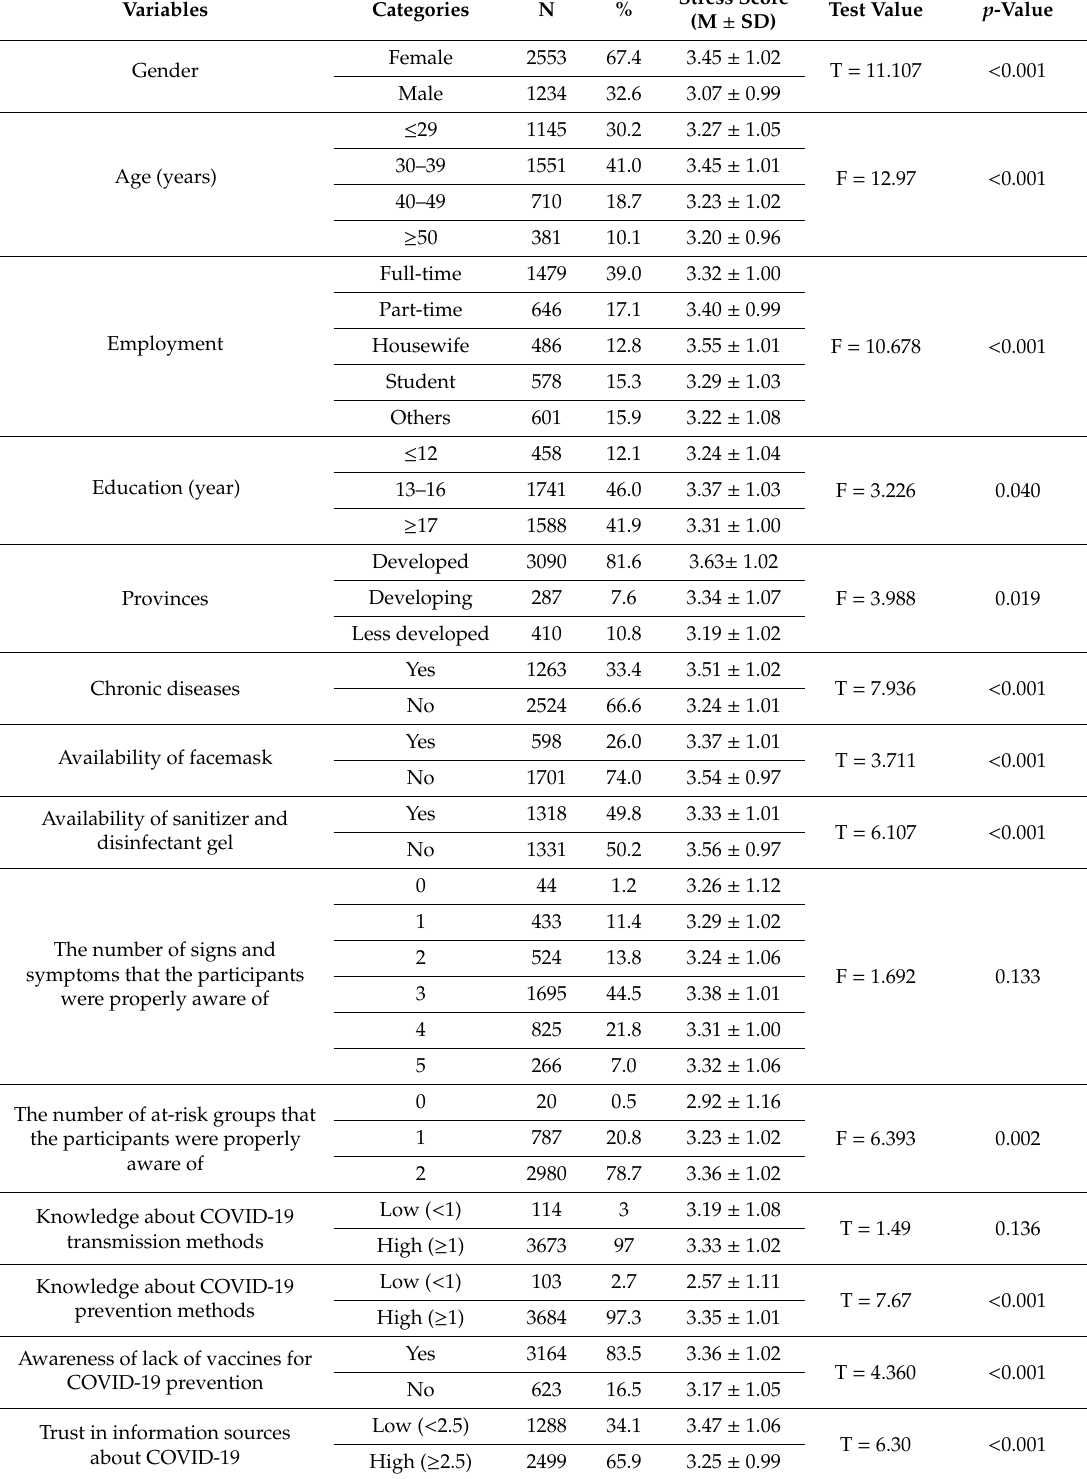
Table 1. Demographic characteristics of the participants and the mean of stress scores in groups.